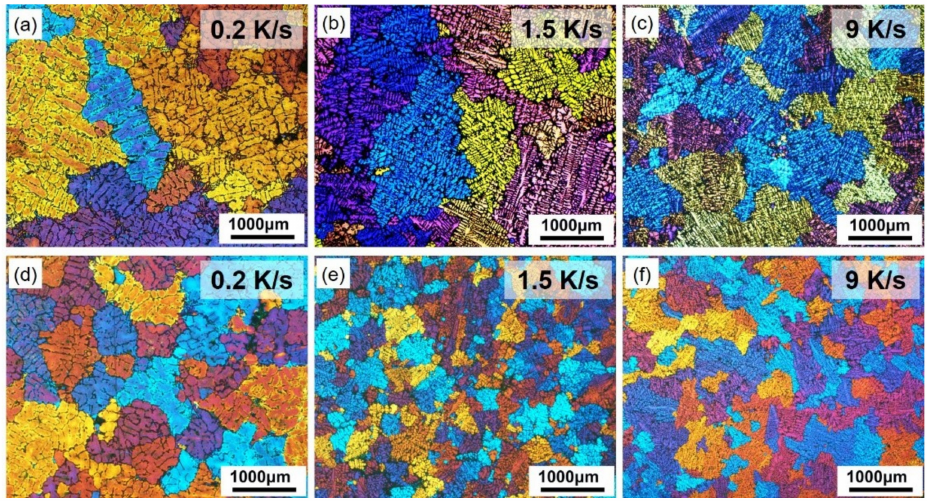
Figure 4. Microstructure in polarized light showing the α -Al grains of ( a – c ) Al7SiMg and ( d – f ) Al7SiMg + 0.4La alloys in di ff erent cooling